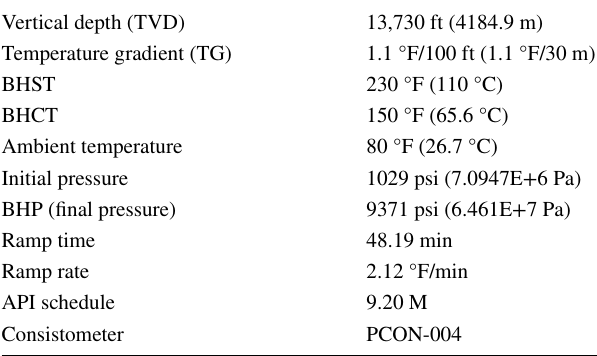
Table 1 Cement slurry design parameters using Bentonite and Mucuna solannie extenders at 150 and 200 °F BHCT